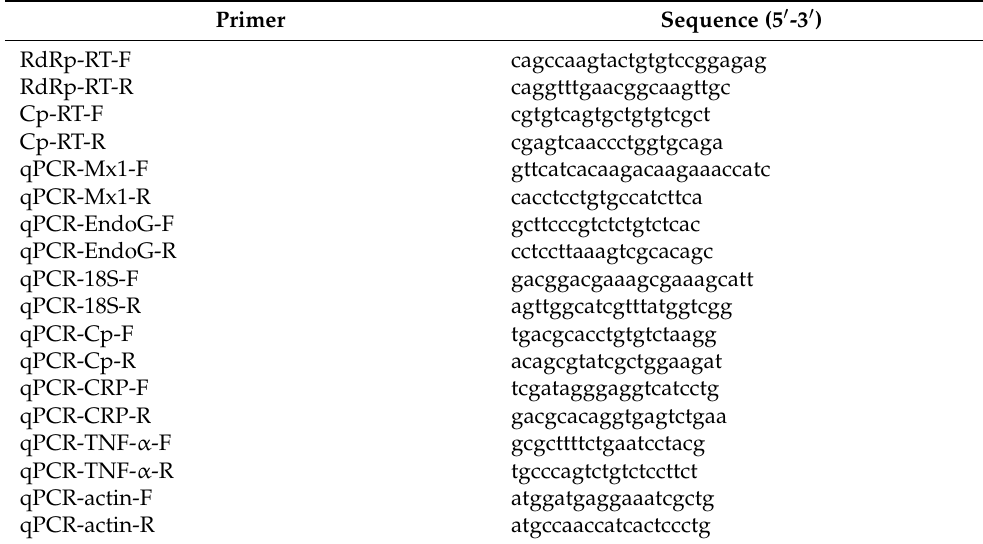
Table 1. Three replicates for each treatment were analyzed. Table 1. Primers for RT-PCR and